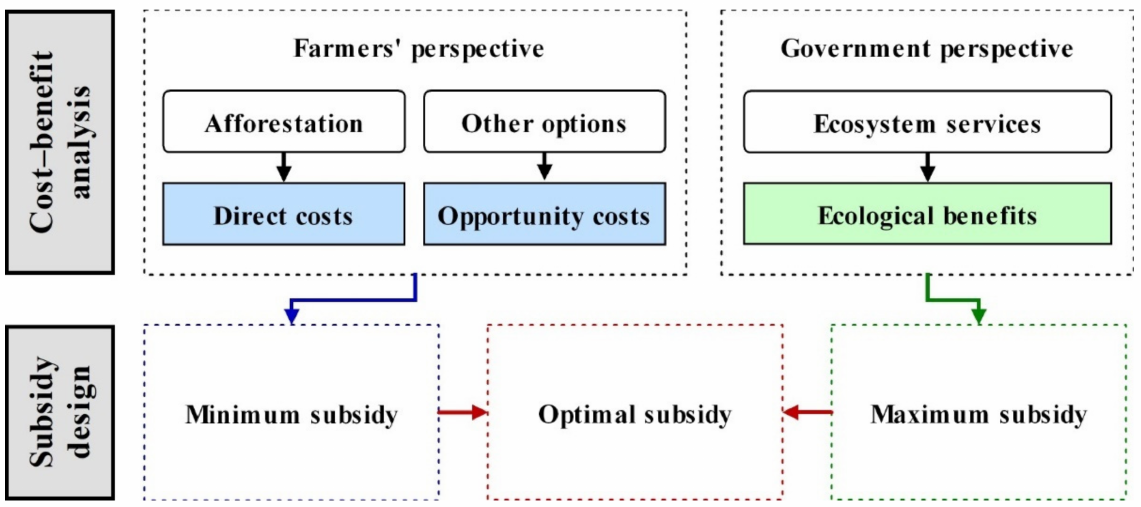
Figure 1. Research framework for determining the afforestation subsidy